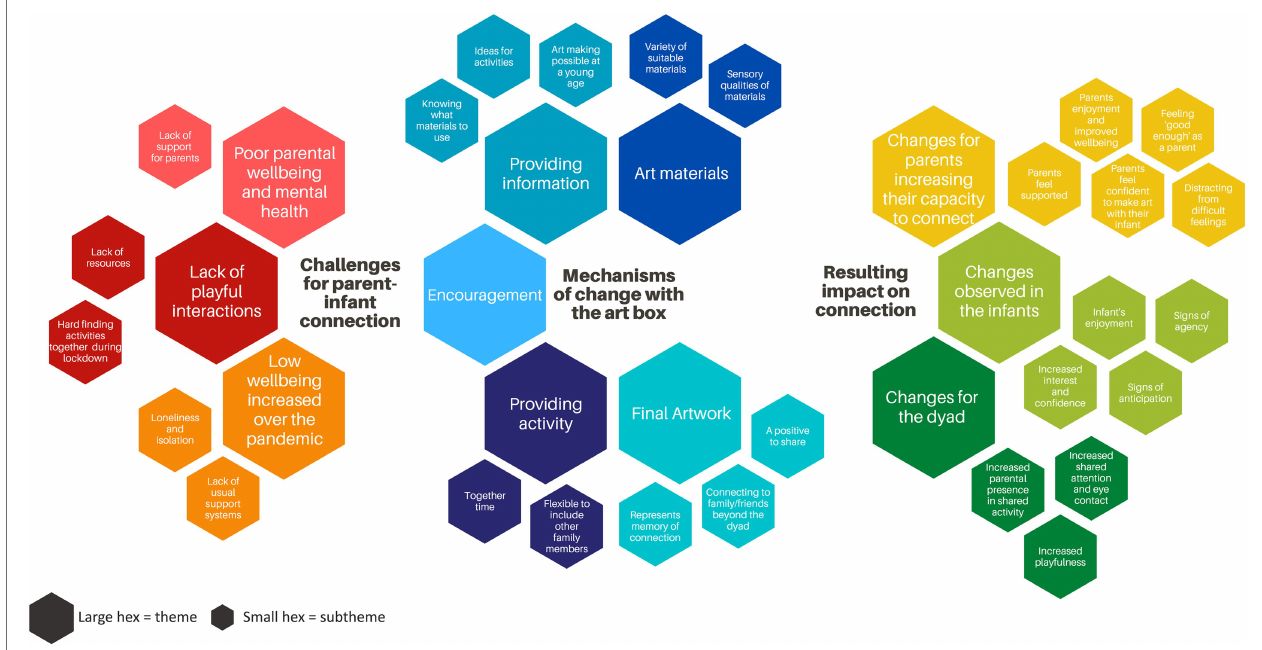
FIGURE 5 | Diagram describing organisation of themes from thematic